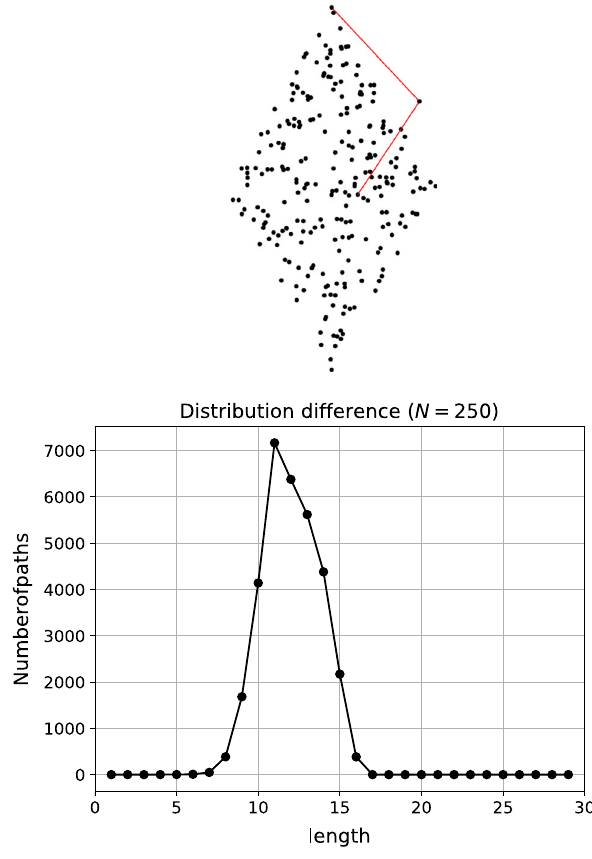
Fig. 7 Top:causalsetobtainedfromsprinklingin2DMinkowskispace andoneaddedpointwith“non-local”links.Bottom:differencebetween the path length distributions